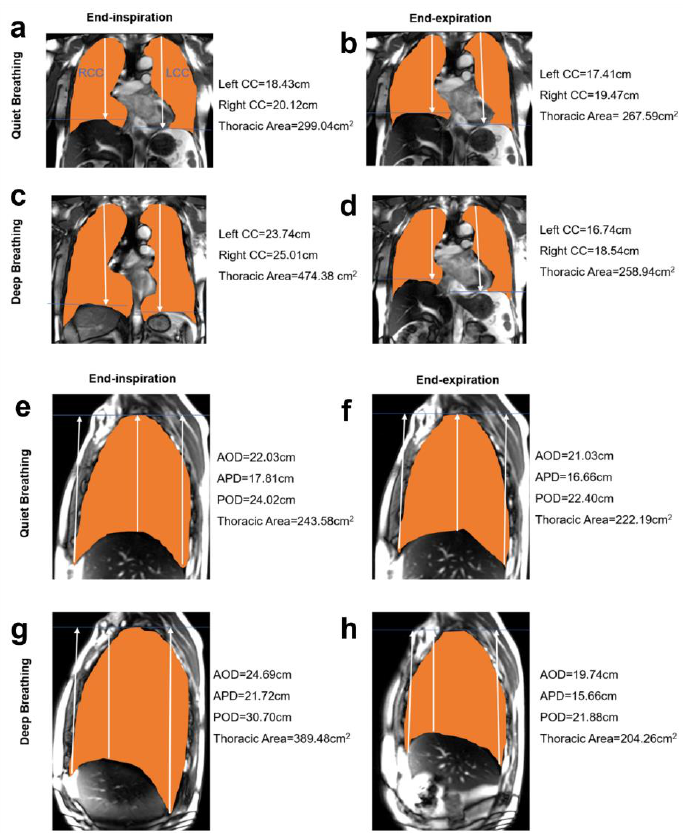
Figure 5. Chest wall and diaphragmatic motion metrics on the coronal plane and sagittal plane in a 50-year-old non-smoker. ( a – d ) The right, left CC, and thoracic area on the coronal plane in end-inspiration and end-expiration. ( e – h ) The AOD, APD, POD, and thoracic area on the sagittal plane in end-inspiration and